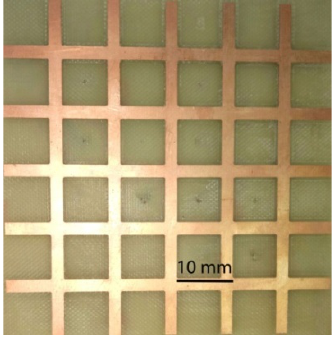
Figure 6: Prototype of one layer fabricated structure.